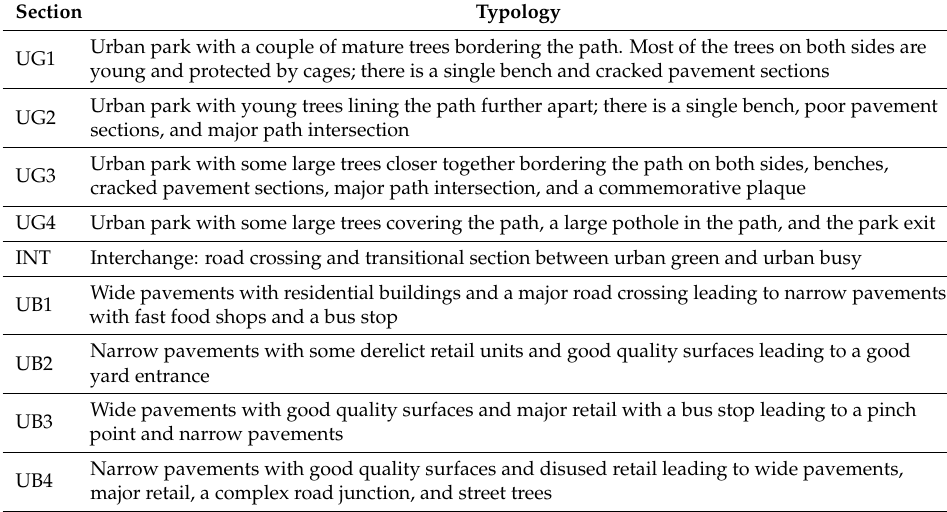
Table 2. An overview and typology of the quartiles from urban green to urban busy derived from Geographic Information System